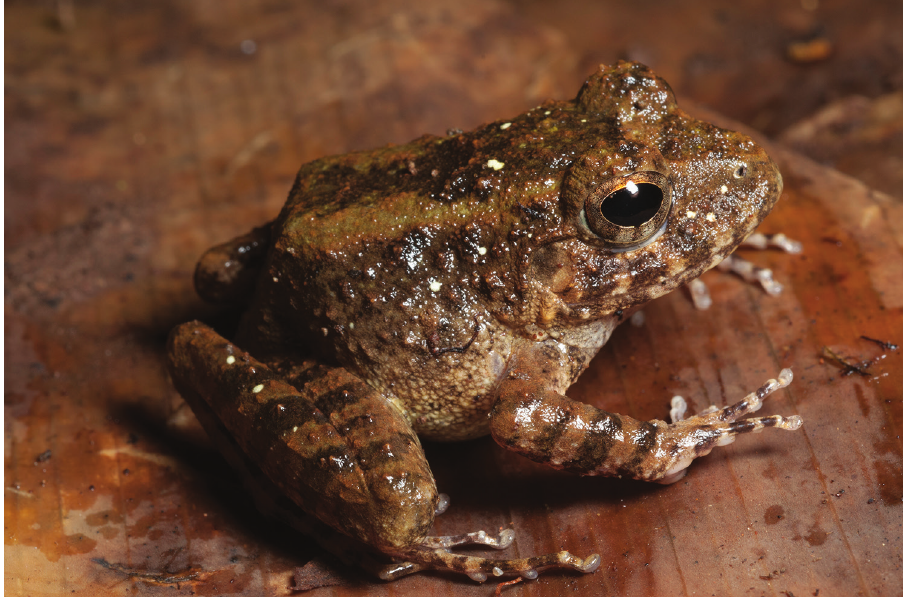
Figure 9. Platymantis sp. “Clicker” male (KU 334508) a species recorded but uncollected at 300 masl, Eye Falls, Mt. Hilong-hilong, Municipality of Remedios T. Romualdez, Agusan del Norte Province, Mindanao Island. This photo (by RMB) was taken at Pasonanca Natural Park, Zamboanga